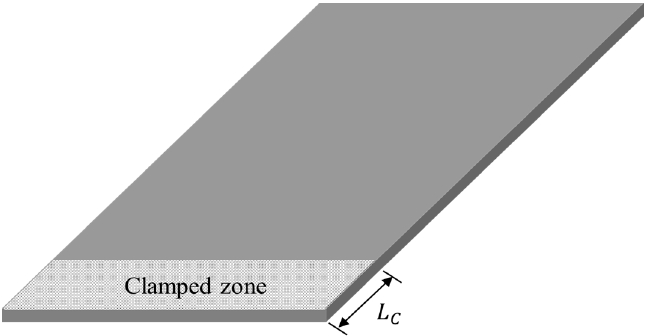
Figure 4. Configuration of the clamped zone in the CFRP specimen: L C = 40 mm.